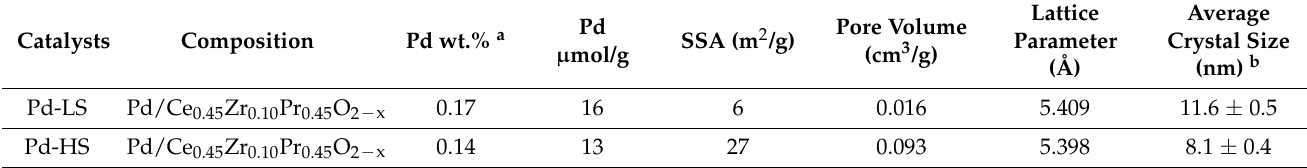
Table 1. Catalysts characterization by means of N 2 -physisorption, XRD and elemental analysis.